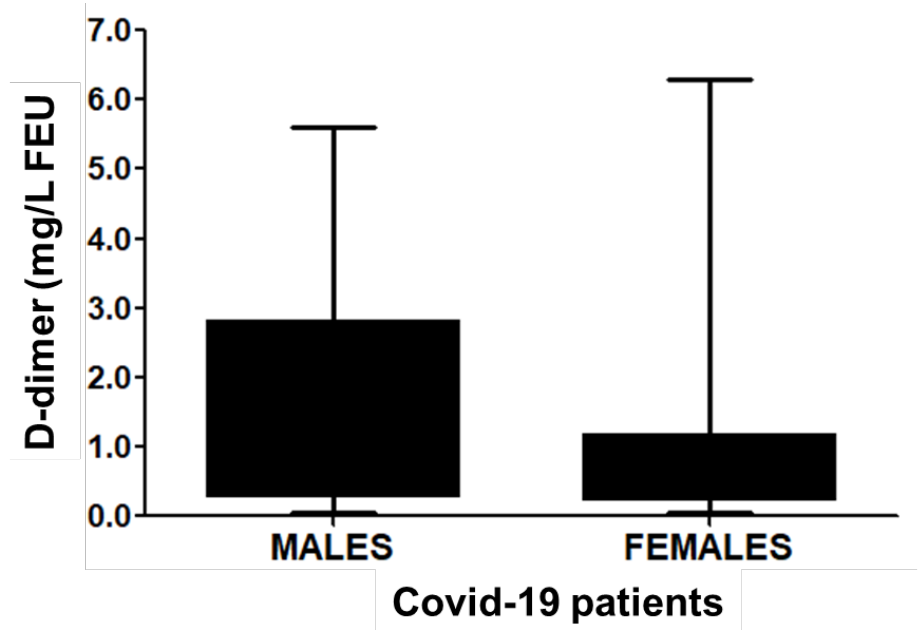
Figure 2. D-dimer levels in male and female COVID-19 patients. Of the COVID-19 patients, levels of D-dimer in the blood samples of males ( n = 97) and females ( n = 51) were measured. Male COVID-19 patients vs. female COVID-19 patients, p = 0.4488 (95% CI -0.4277 to 0.9575). Box and Whisker show the Min to Max values with median ± SD.